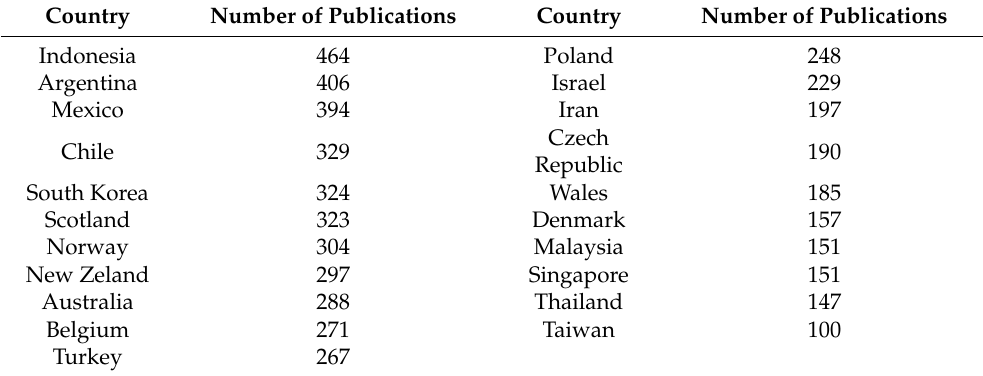
Table 5. Number of publications by countries which have publications between 100 and 499 (Group B